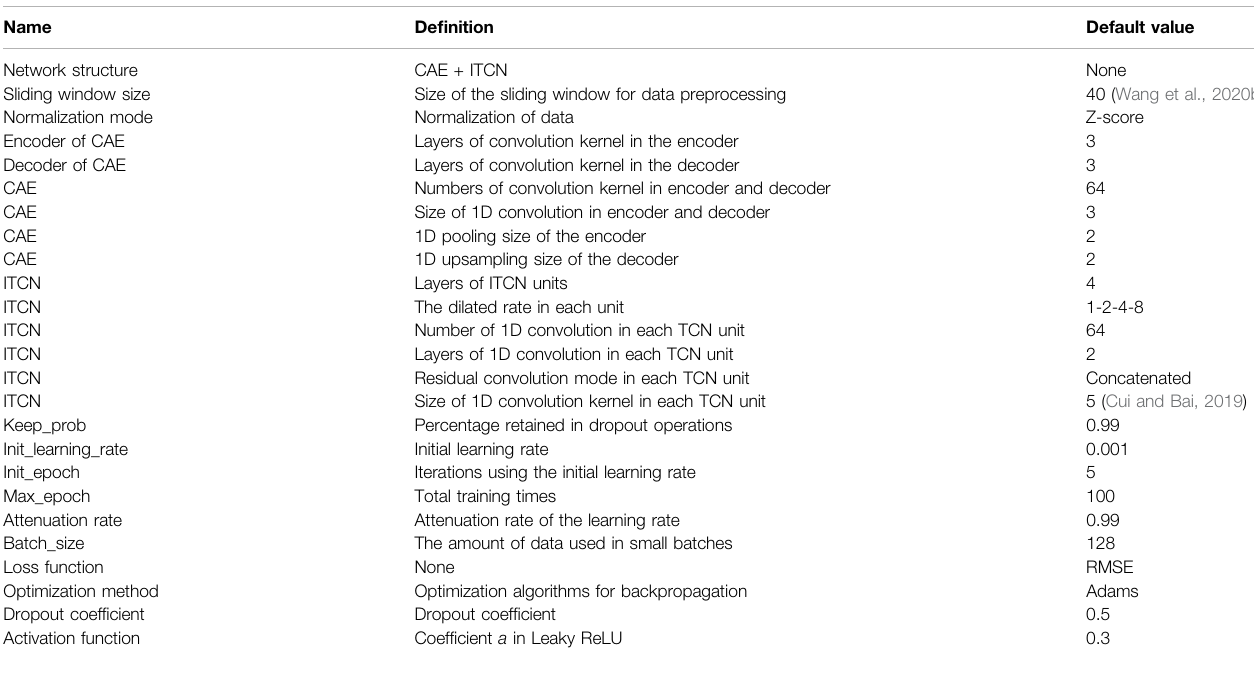
TABLE 1 | The architecture de fi nition of